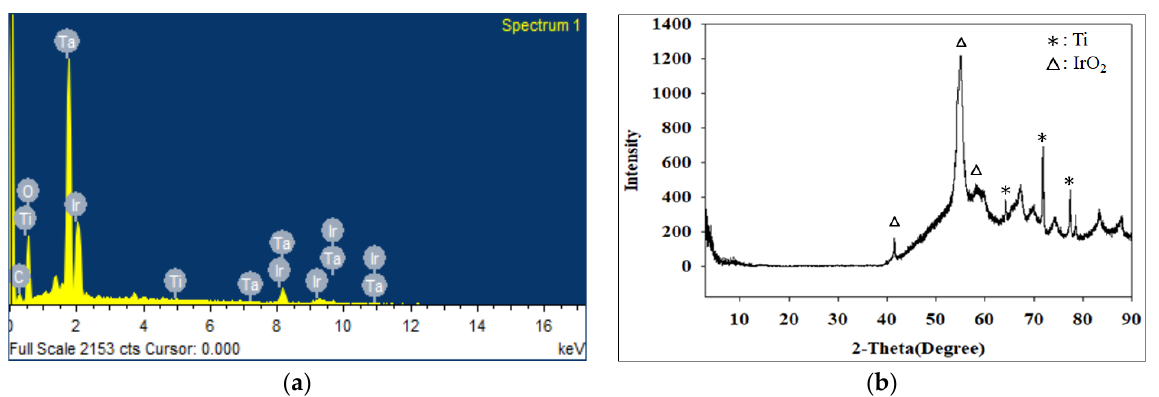
Figure 1. The element and microstructural analysis of IrO 2 -Ta 2 O 5 /Ti electrode: ( a ) EDS spectrum; ( b ) XRD diffraction spectrum.